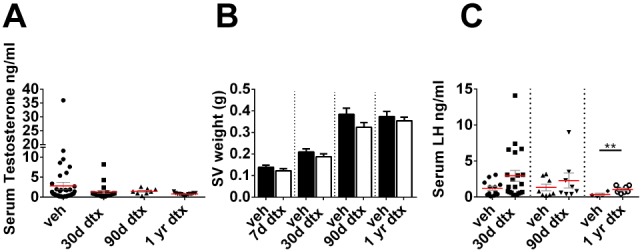
Adult Leydig Cell functionally compensate following Sertoli cell ablation in adulthood.(A) Serum testosterone (one-way ANOVA n = 7–14) (B) Seminal Vesicle weight (T-test n = 8–12) and (C) Luteinizing Hormone concentrations (T-test n =  n = 7–14, **P<0.01) in adulthood following Sertoli cell ablation at different ages. d,days; yr,year; dtx, injected with toxin; veh: vehicle control; SV:seminal vesicle.